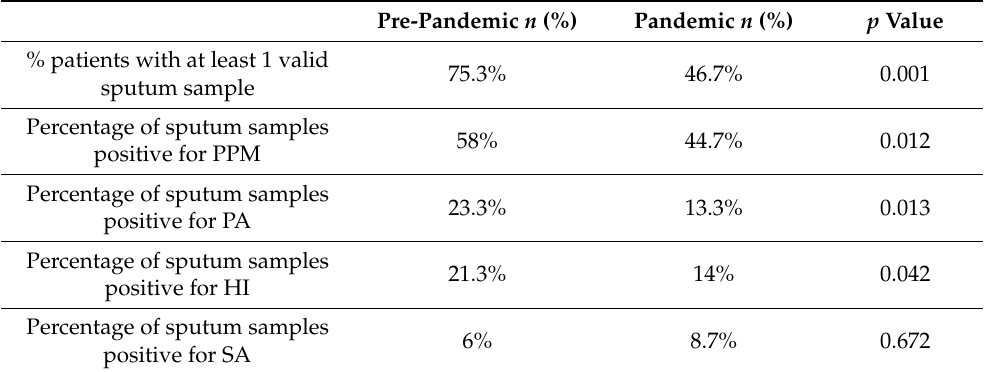
Table 3. Percentage of positive sputum samples for potentially pathogenic microorganisms during the pre-pandemic and pandemic periods.